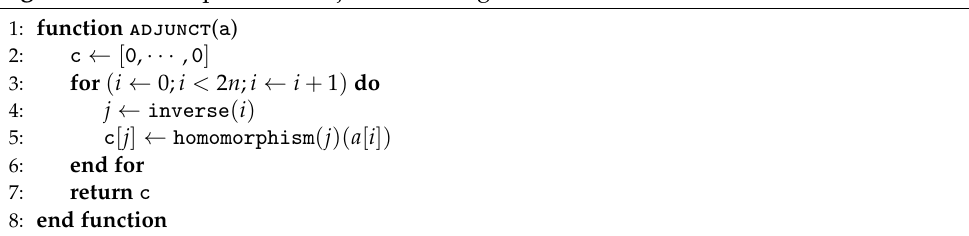
Algorithm 14 Computes the adjunct of a ring